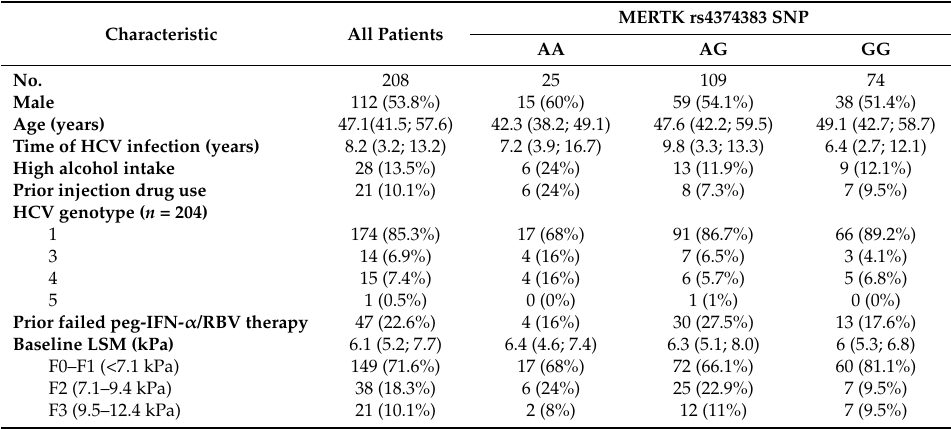
Table 1. Clinical and epidemiological characteristics of HCV-infected patients stratified by MERTK rs4374383